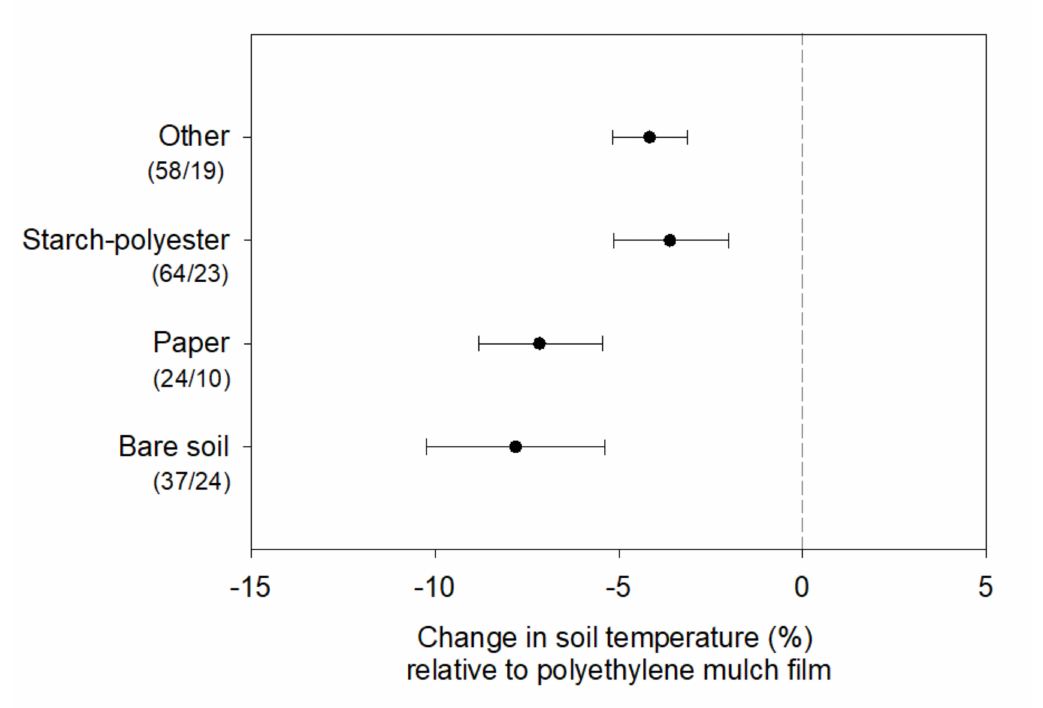
Figure 2. Mean change in soil temperature as influenced by bare soil and biodegradable mulch type (relative to polyethylene mulch film). Numbers below y-axis labels indicate the number of observations and studies (left / right, respectively) contributing to each mean. Error bars represent 95% confidence intervals determined via